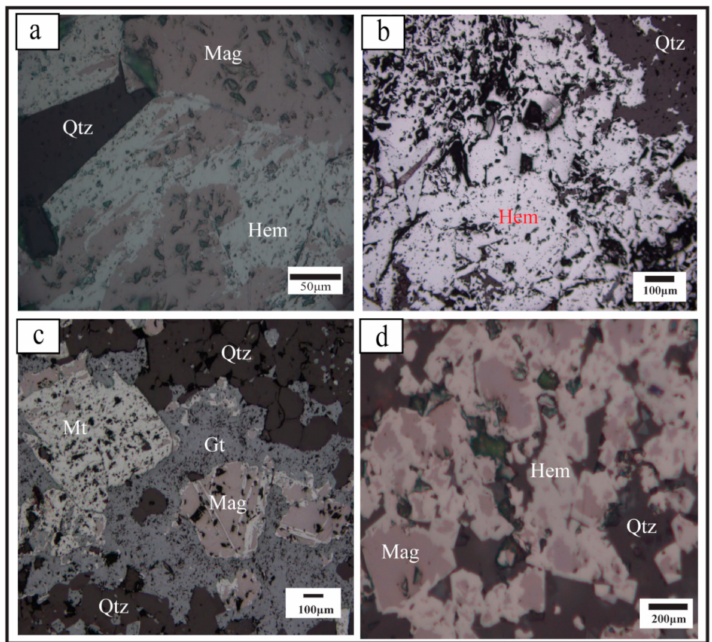
Figure 5. Photomicrographs of the Nabeba oxide facies-BIF: ( a ) anhedral magnetite partially replaced by hematite (sample CG-C2, reflected-light); ( b ) hematite, which has completely replaced magnetite (sample CG-C2, reflected-light); ( c ) granoblastic martite in magnetite pseudomorph with interstitial goethite (sample CG-C5, reflected-light); ( d ) subhedral-anhedral magnetite partially replaced by hematite at grain boundaries (sample CG-C23, reflected-light). Abbreviations: Gt, goethite; Hem, hematite; Mag, magnetite; Mt, martite; Qtz,